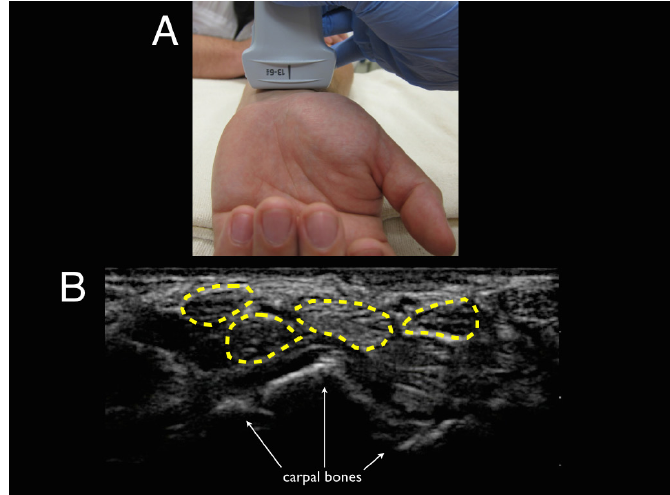
Figure 2 . Ultrasound technique and visualization. (A) Appropriate placement of the linear transducer (13MHz to 6MHz) at the wrist crease in transverse plane to evaluate for flexor tenosynovitis. (B) Ultrasound image in transverse view showing normal flexor tendons (highlighted in yellow) with no surrounding edema. The flexor tendons should lie anterior to the carpal bones identified by arrows for